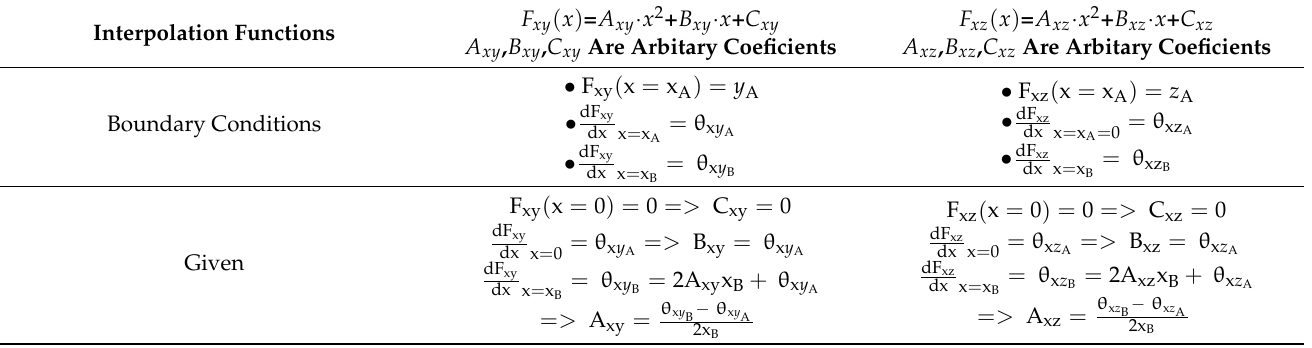
Table 1. Interpolation Functions & Boundary Conditions, Node Displacements Calculation for Riser Profile